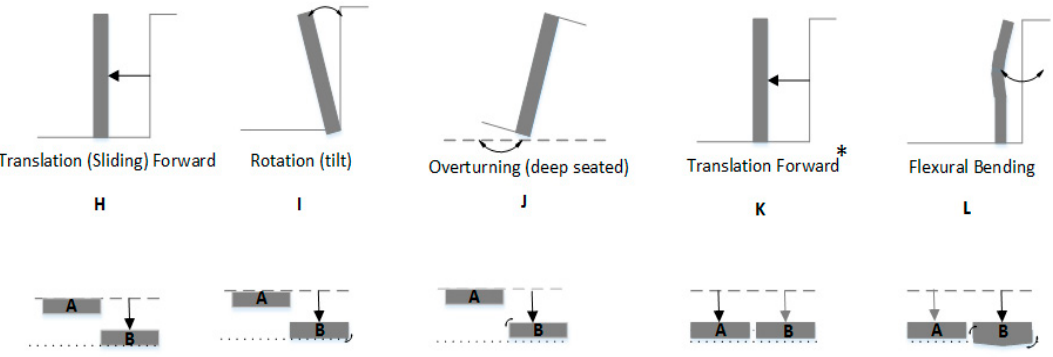
Figure 1. Visual of retaining wall failure modes with an accompanying plan view illustration . * Repeated failure mode on wall section B.